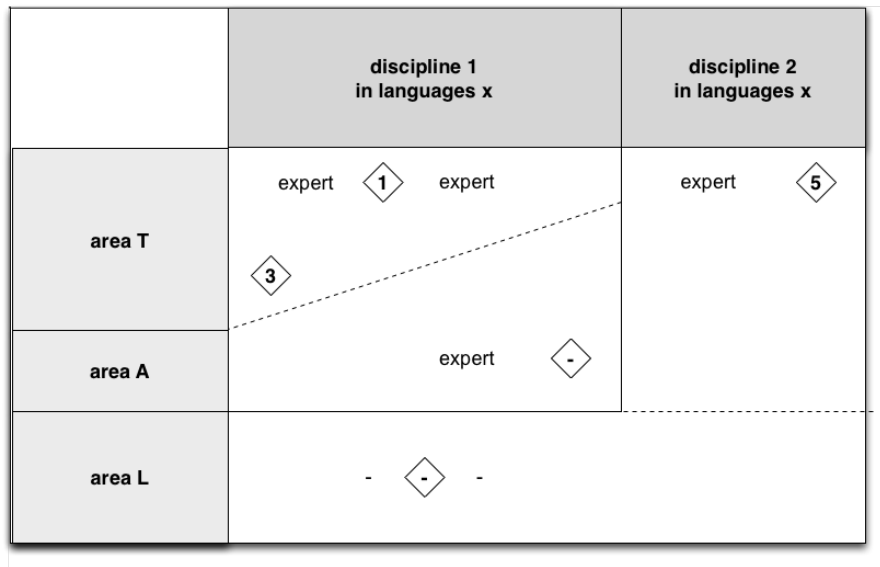
Fig. 7: interdisciplinary research project in the planning phase Later, in the phase of data collection, it is necessary to apply the revised model (see figure 8 below):